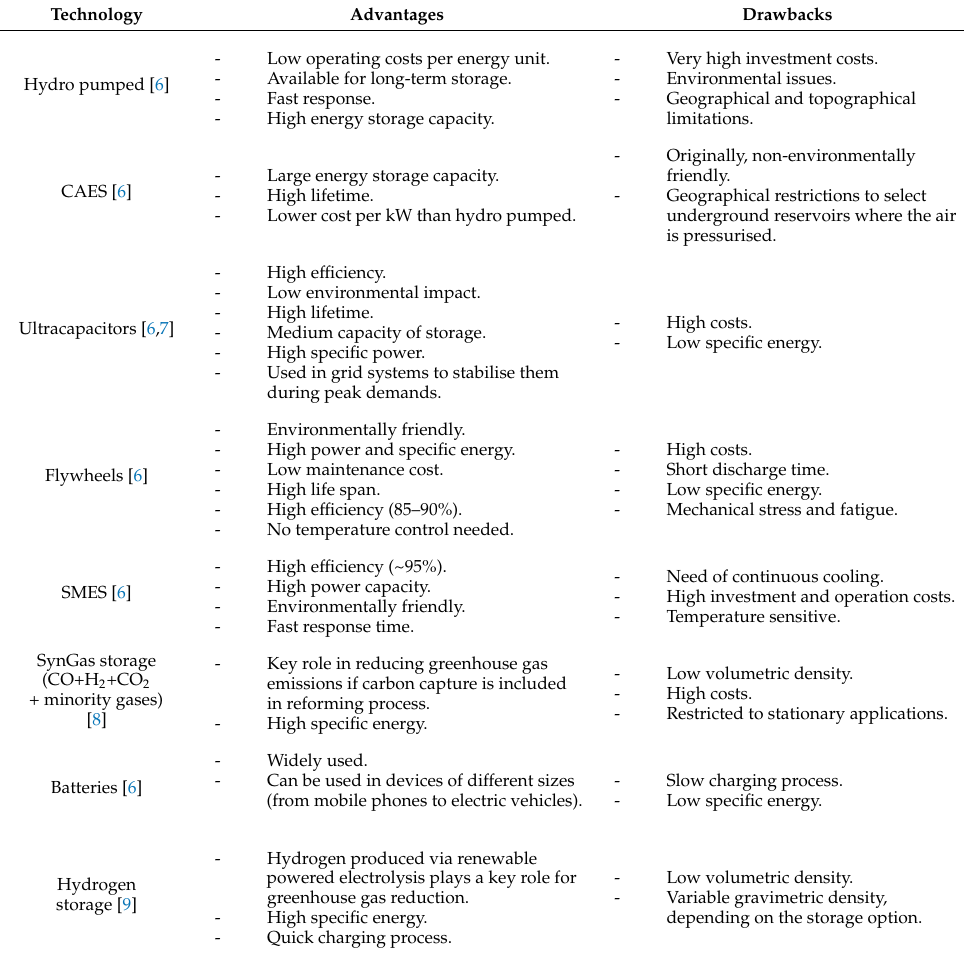
Table 1. Advantages and drawbacks of different